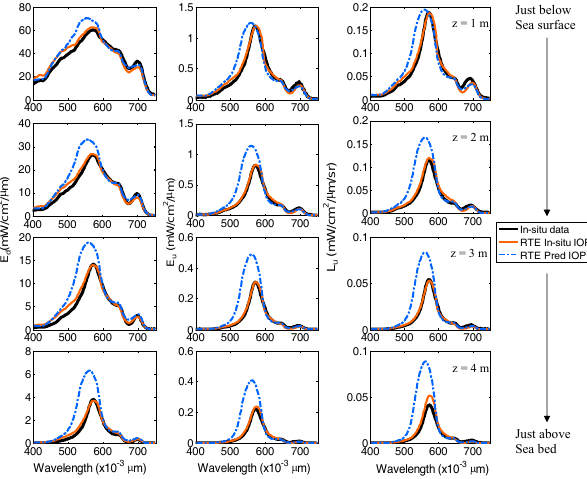
Figure 14. Spectral comparisons of the simulated and measured un- derwater light fields ( E d , E u and L u ) for four discrete depths in phytoplankton-dominated harbour waters off Chennai (St-7). The black colour represents the measured data, orange colour represents results from the present RT model using in situ IOP data, and the blue colour represents results from the present RT model using the predicted IOPs from the remote-sensing reflectance data.